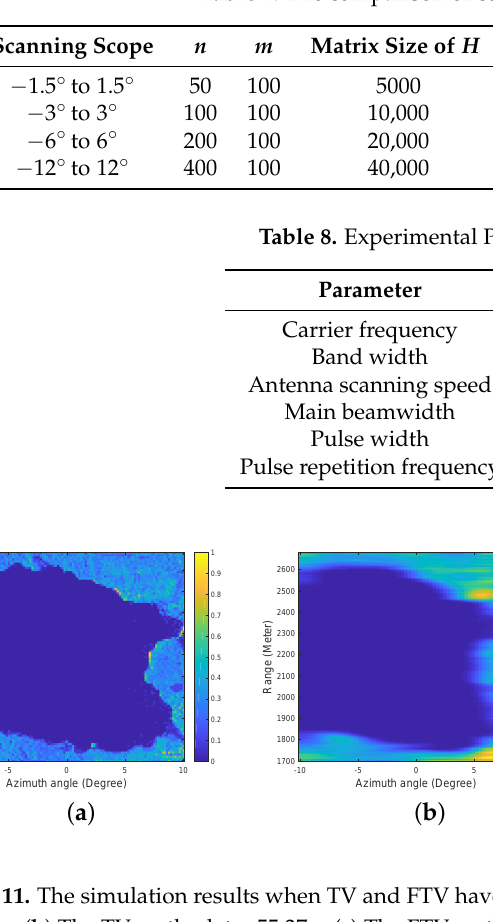
Figure 10. Computation time curve of IRN-TV and IRN-FTV. Table 7. The comparison of computation time.